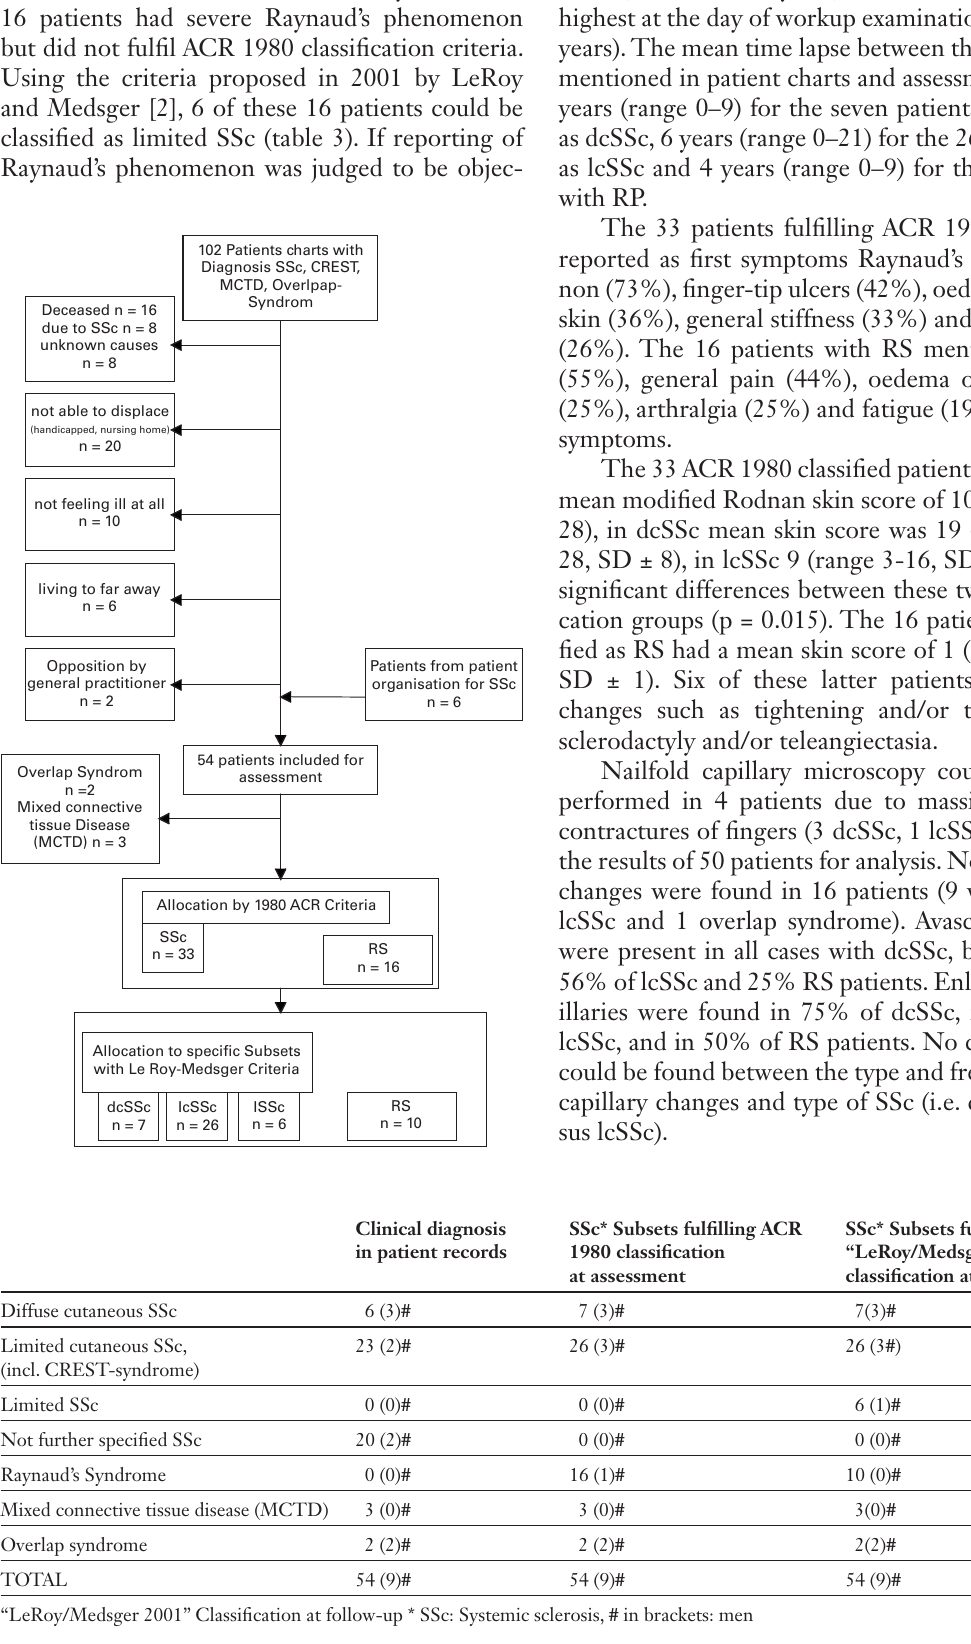
Figure 1 Flow-chart.